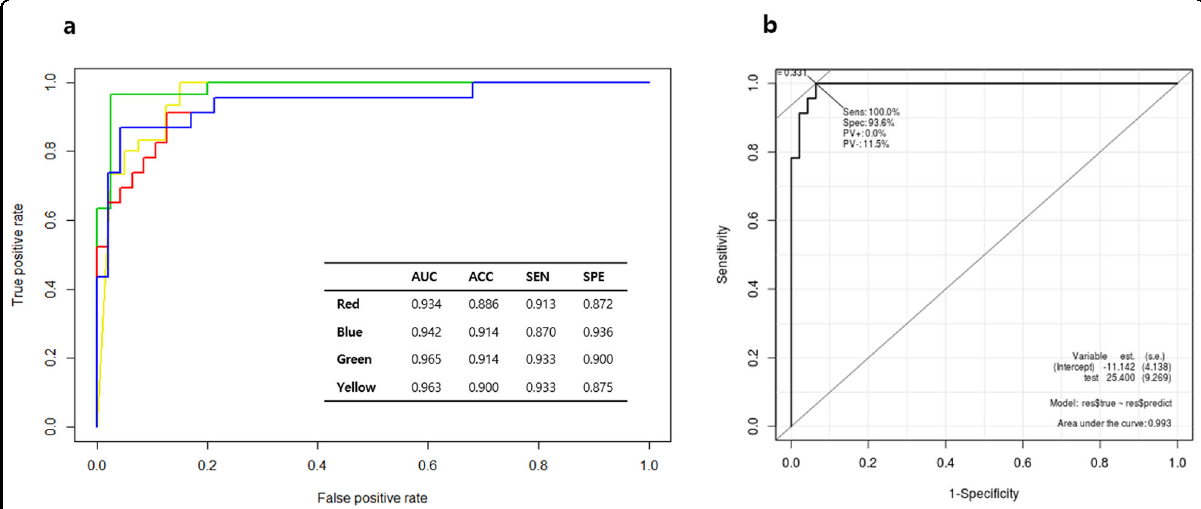
Fig. 4 Brain tumor diagnostic models based on the serum EV microbiome at the genus level. Receiver operating characteristic (ROC) curves for ( a ) stepwise selection-based M1 (red) and M2 (blue) models, linear discriminant analysis effect size (LEfSe)-based M3 (green) and M4 (yellow) models, and ( b ) ROC curve for AI-based M5